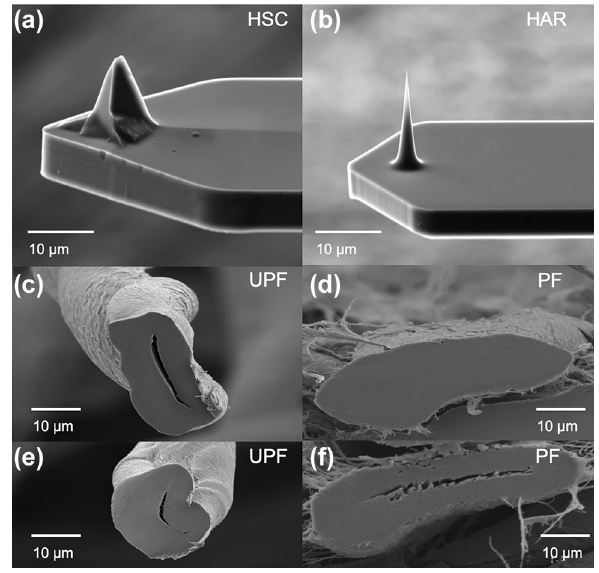
Fig. 2 SE images of the tip geometry for a the HSC cantilever and b the HAR cantilever. SE images of cross sections for UPF in ( c ) and ( e ) and for PF in ( d ) and ( f